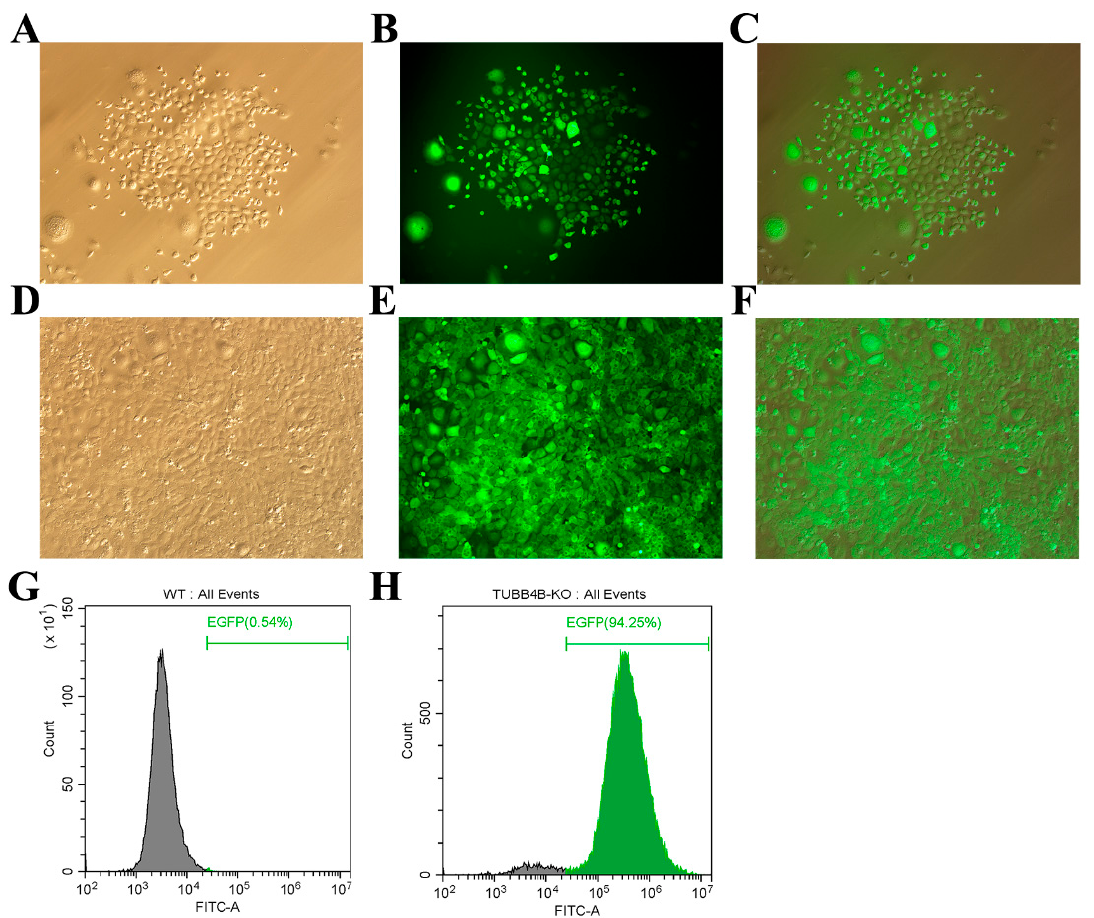
Figure 2. TUBB4B-KO mouse spermatogonia screening 100 × . ( A , B ): White light and fluorescence images of mouse spermatogonia selected after virus infection; ( C ): Merge results of ( A ) and ( B ). ( D , E ): White light and fluorescence of mouse spermatogonia of TUBB4B-KO; ( F ): Merge result of ( D , E ). ( G ): Flow cytometry to detect the expression of fluorescent protein in control mouse spermatogonia; ( H ): Flow cytometry to detect the expression of fluorescent protein in Tubb4b -KO mouse spermatogonia. Note: Green numbers indicate the proportion of cells expressing EGFP protein in control or Tubb4b -KO mouse spermatogonia.